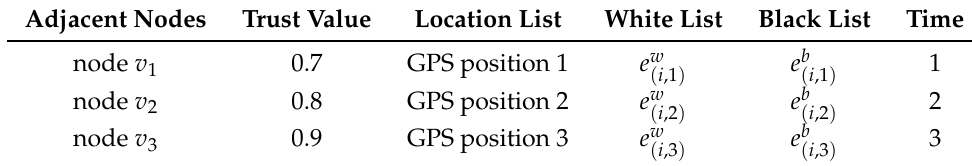
Table 1. Trust table of node v i . Adjacent